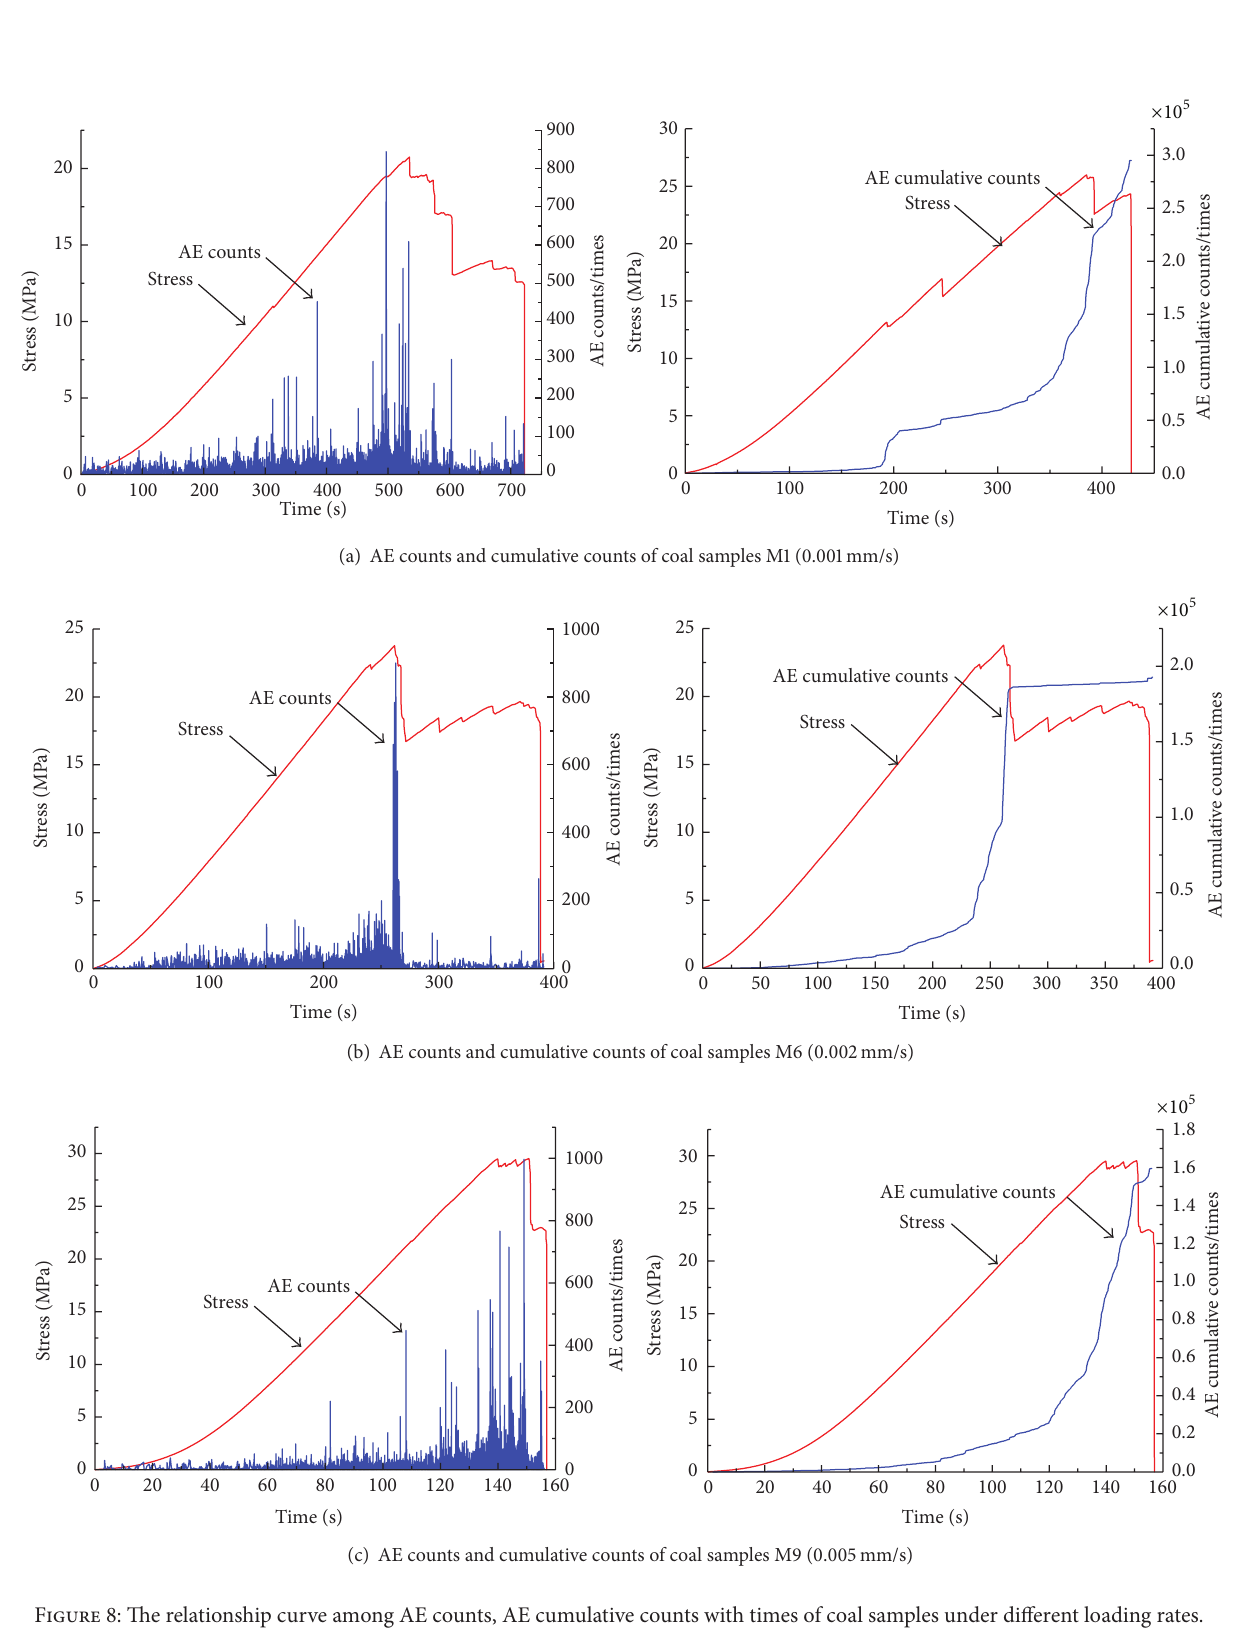
Figure 8: The relationship curve among AE counts, AE cumulative counts with times of coal samples under different loading